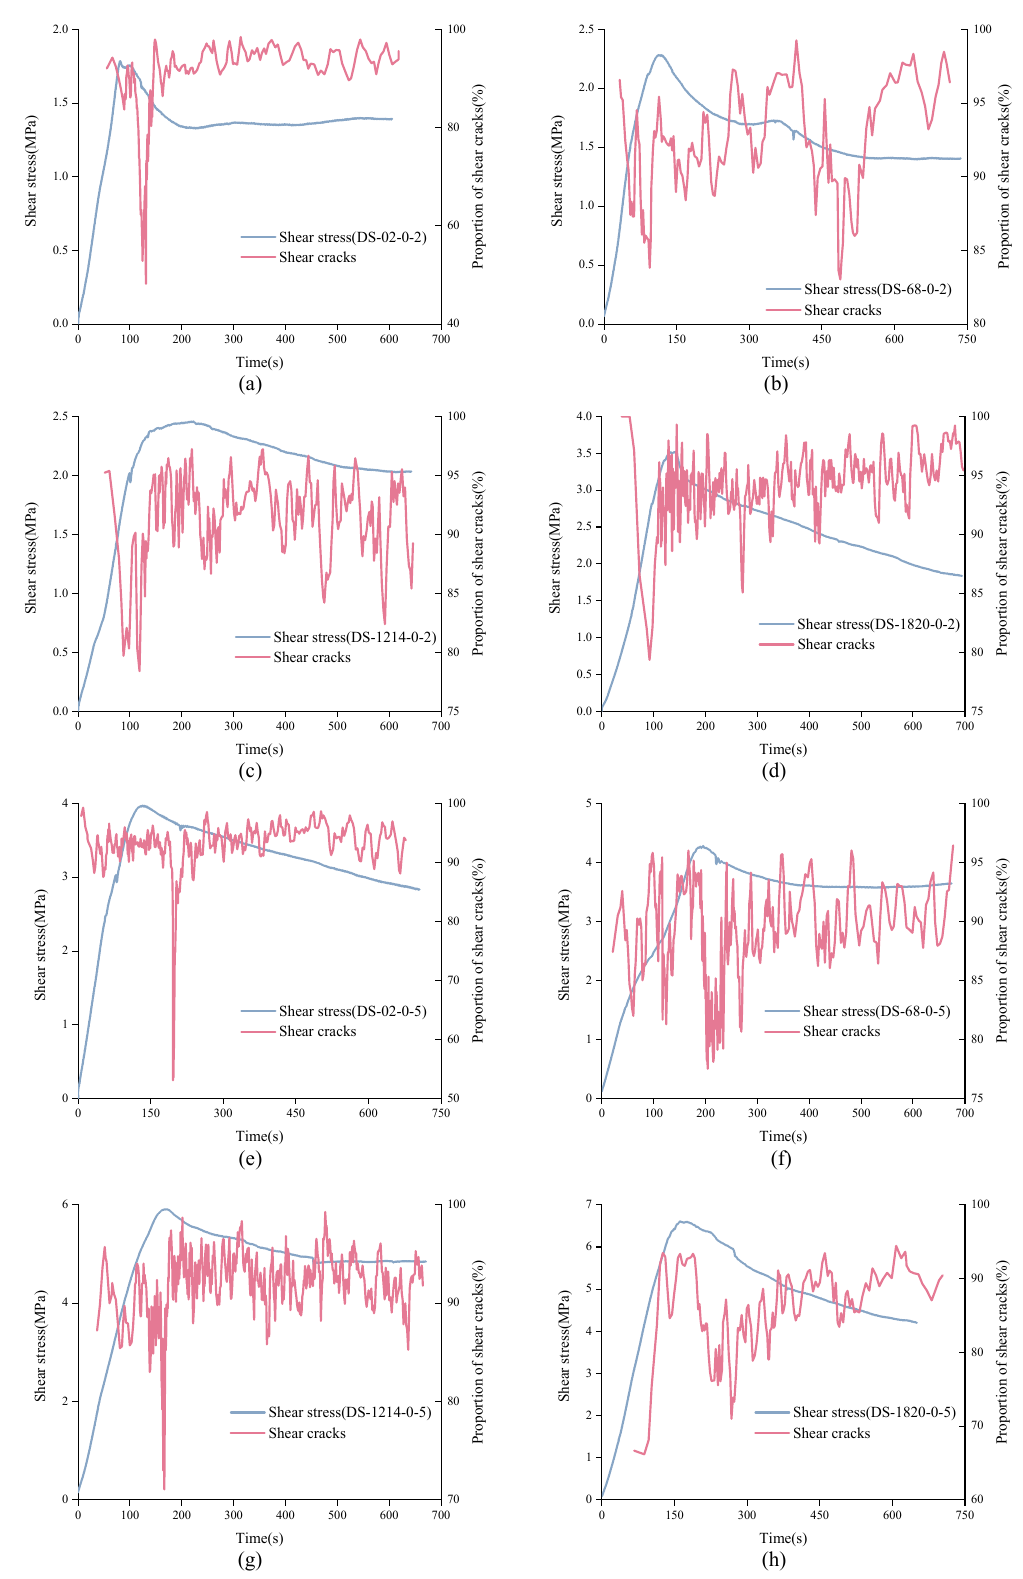
Figure 17. Variation trend of real-time shear cracks’ proportion curves of unanchored structural planes. ( a ) Ds-02-0-2 ( b ) Ds-68-0-2 ( c ) Ds-1214-0-2 ( d ) Ds-1820-0-2 ( e ) Ds-02-0-5 ( f ) Ds-68-0-5 ( g ) Ds-1214-0-5 ( h ) Ds-1820-0-5.